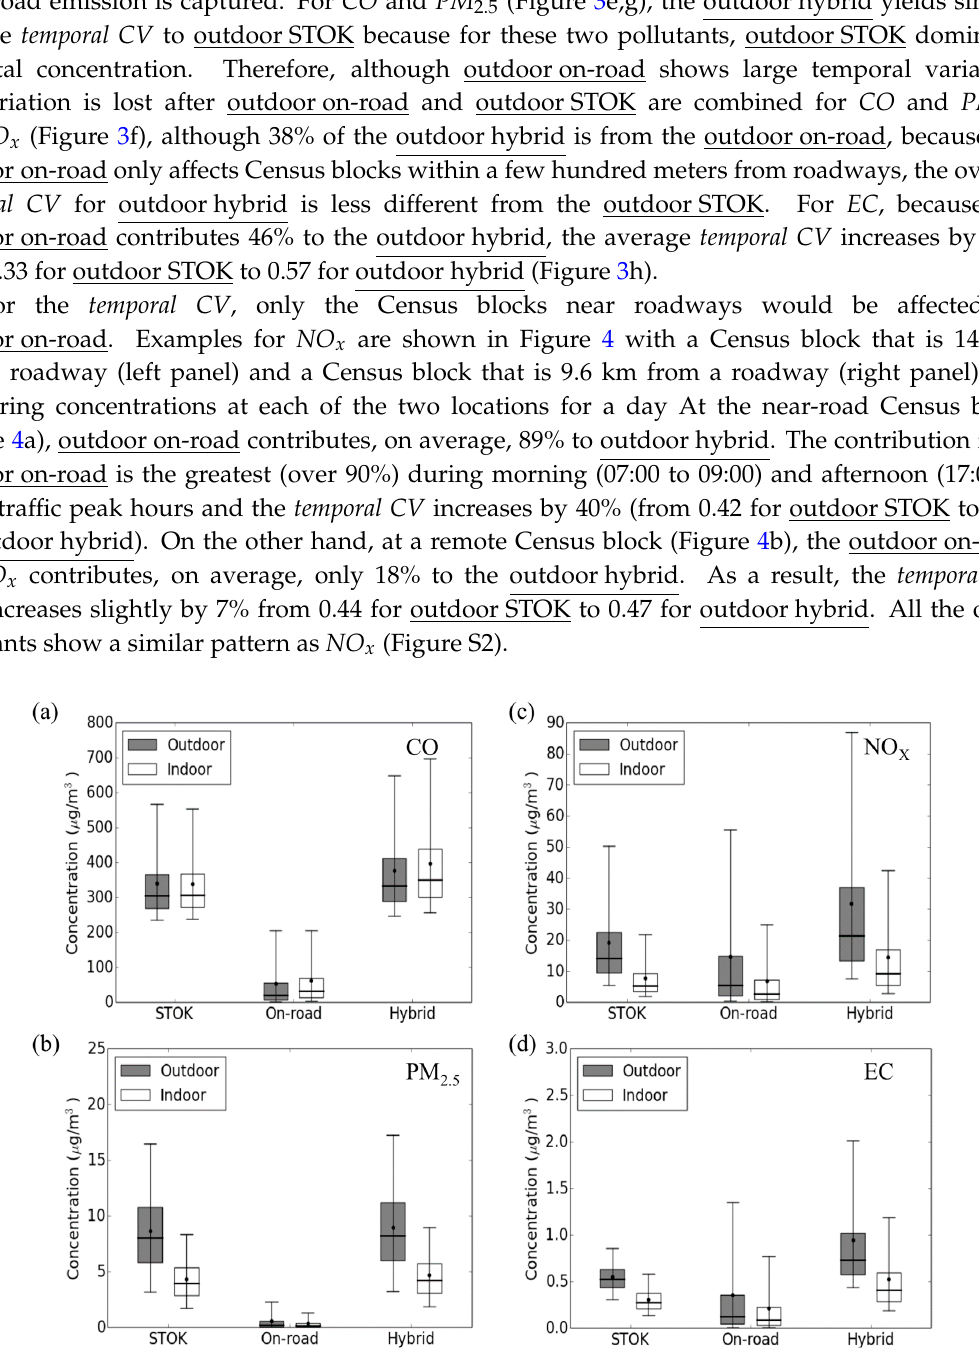
Figure 2. Hourly pollutant concentration for each Census block in Durham, Orange, and Wake Counties, North Carolina (NC) in 2012. ( a ) CO ; ( b ) PM 2.5 ; ( c ) NO x ; and ( d ) EC . Bottom and top of box represents 25th and 75th percentiles, the line in the middle of the box is the median, the ends of the whisker are the 5th and 95th percentiles, and the dot on the whisker is the mean.